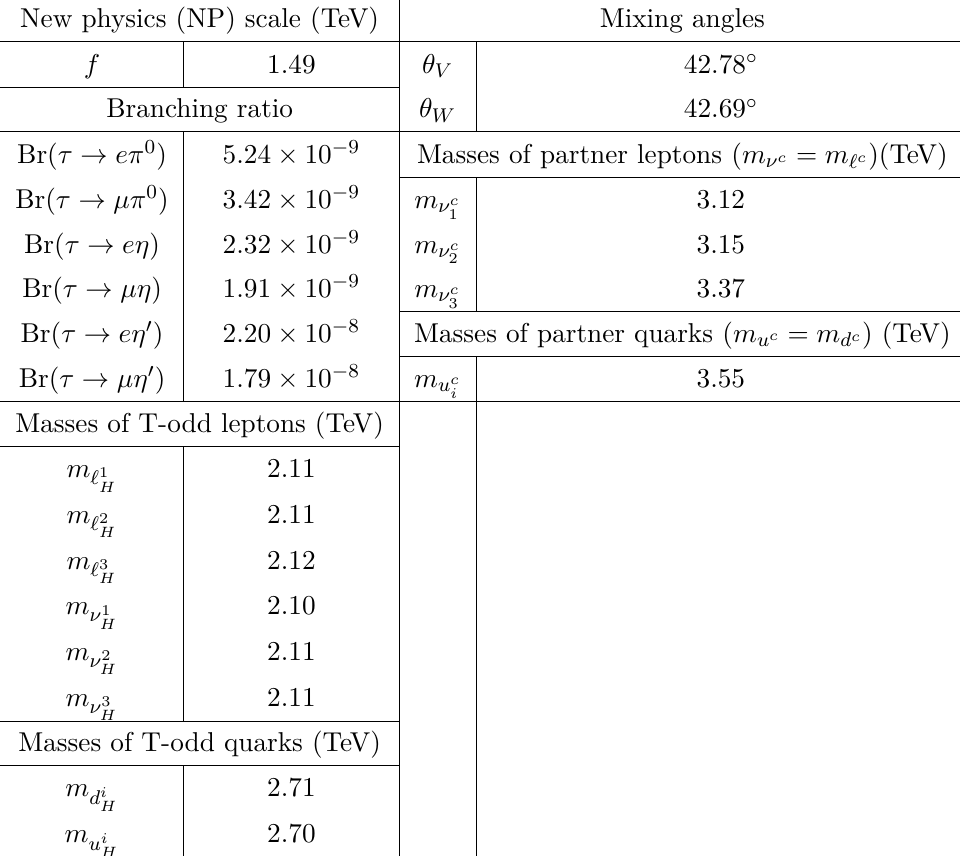
Table 2 . Mean values for branching ratios, masses of LHT heavy particles, and mixing angles obtained by Monte Carlo simulation of τ → ‘P ( ‘ = e, µ ) processes where Majorana neutrinos contribution is not